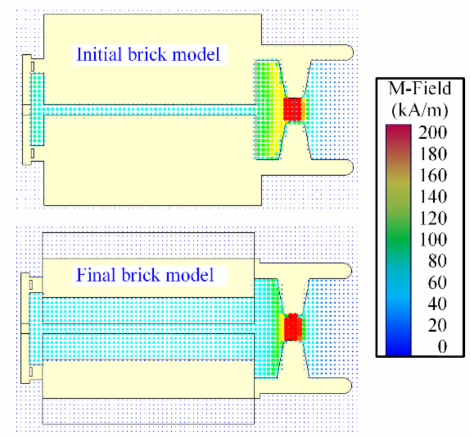
Figure 16. Cross-sectional view of the magnetic field vector at the instant of maximum brick